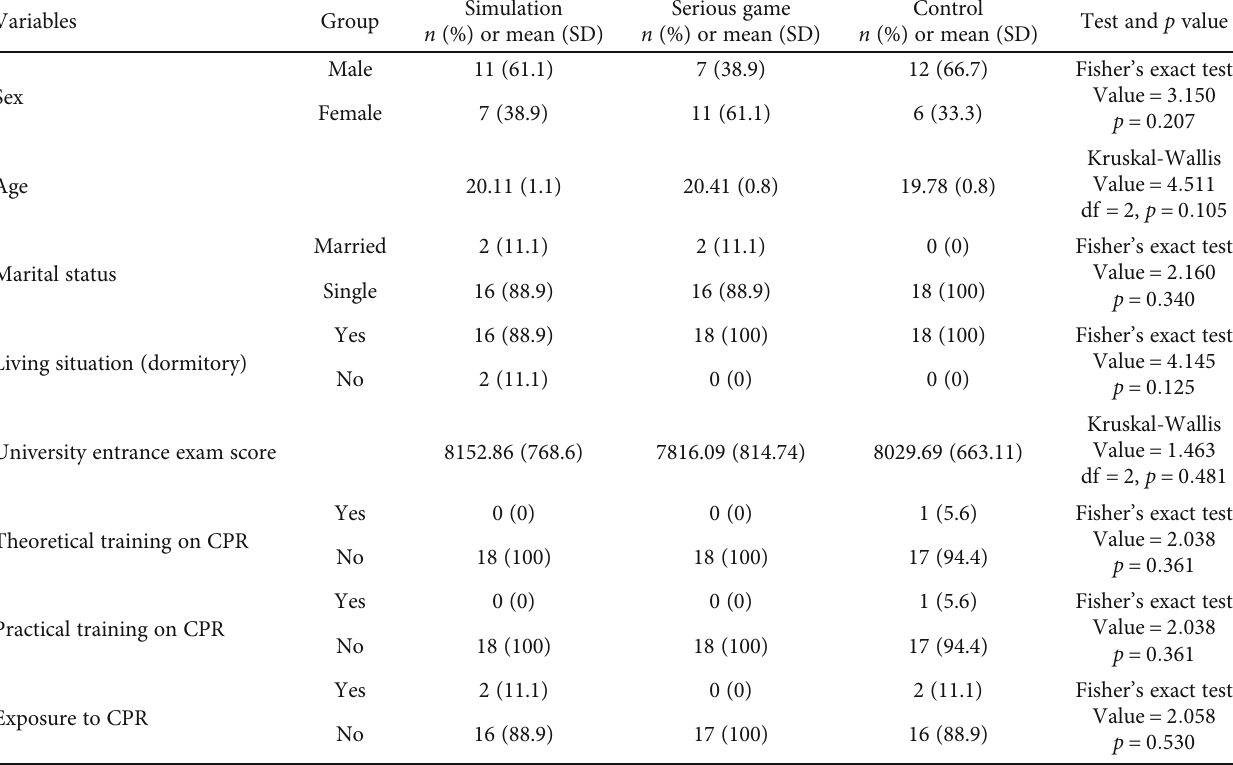
Table 1: Individual characteristics of nursing students in the simulation, serious games, and control